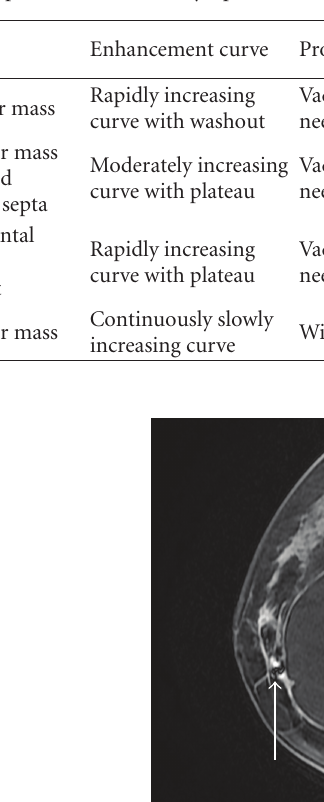
Table 1: Summary of MRI-guided interventional procedures in four asymptomatic silicone-injected breasts.